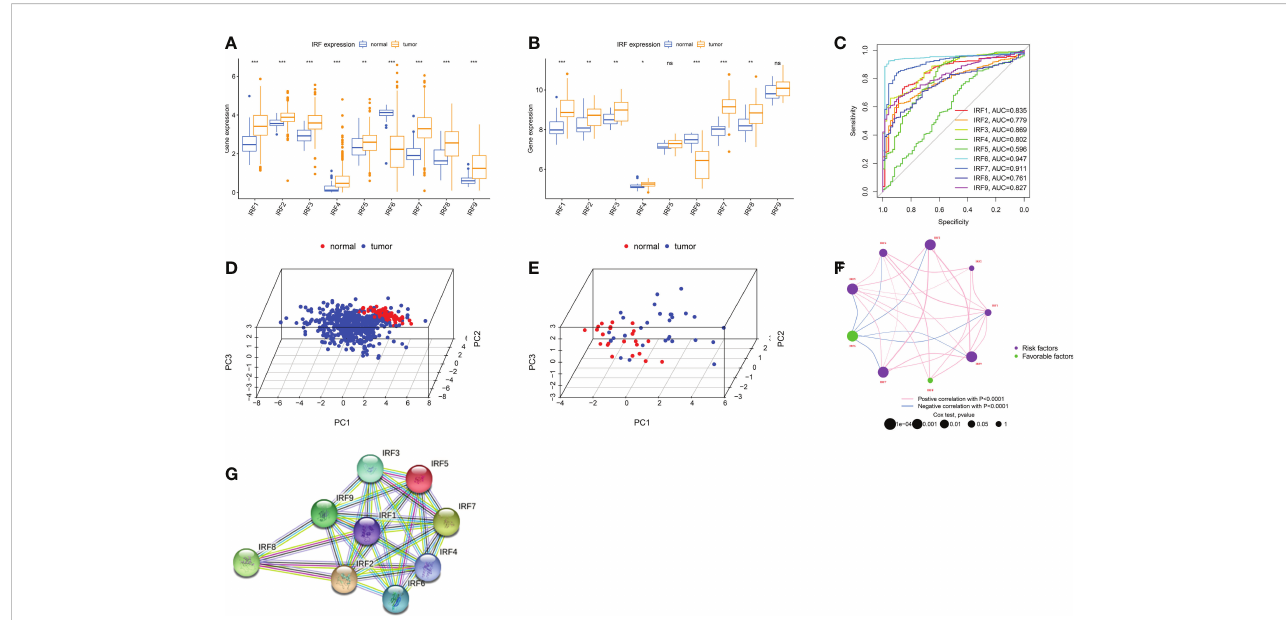
FIGURE 1 Landscape of IRFs expression in ccRCC. (A-B) Boxplot of IRFs expression in ccRCC and normal tissues from TCGA database (A) and GSE36895 (B) . (C) ROC curves demonstrate IRF family ability to differentiate between tumour and normal tissue. (D-E) Principal component analysis for the expression pro fi les of IRFs to distinguish tumours from normal samples in TCGA database (D) and GSE36895 (E) . (F) The interaction between IRFs in ccRCC. (G) The PPI network of IRFs. ns, not signi fi cant; *p < 0.05; **p < 0.01; ***p <